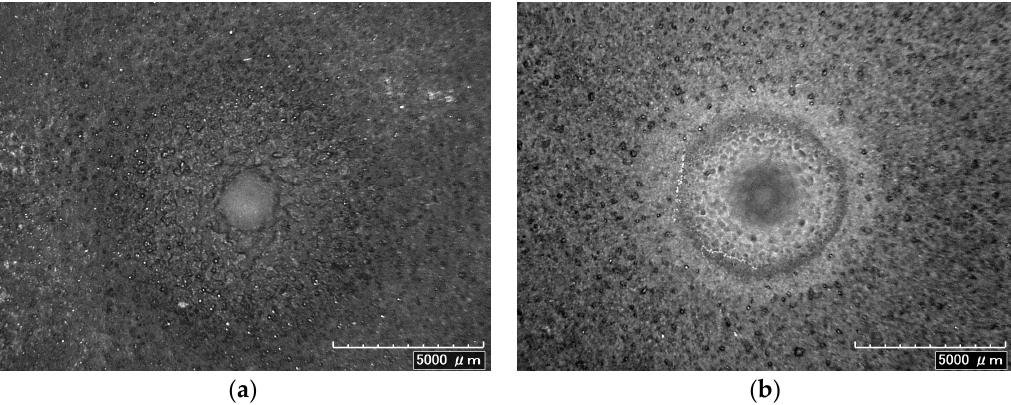
Figure 8. Micrographs of erosion surfaces of the zircon-based ceramics coating after ( a ) 30 ◦ and ( b ) 90 ◦ impingement.